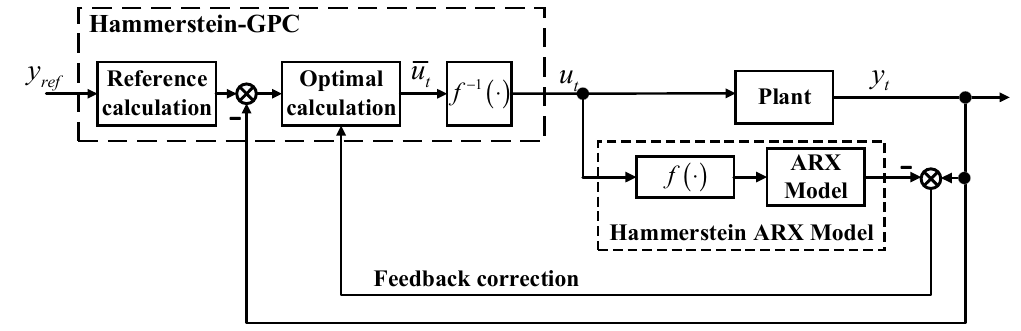
Figure 4. Structure of Hammerstein-GPC.